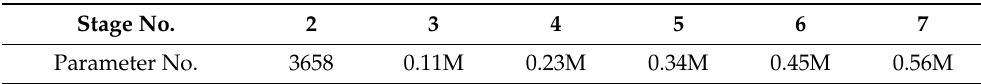
Table 13. Parameters of different depth.